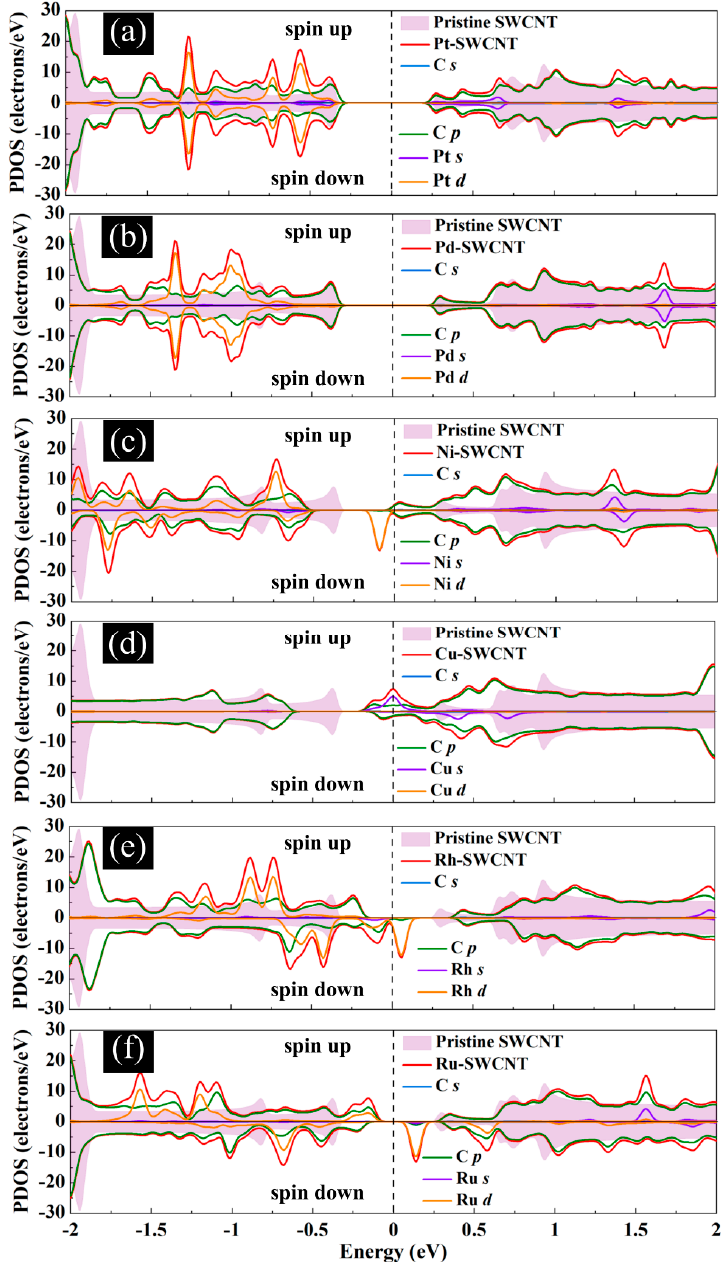
Figure 6. Total DOS curves for pristine SWCNT and ( a ) Pt-SWCNT, ( b ) Pd-SWCNT, ( c ) Ni-SWCNT, ( d ) Cu-SWCNT, ( e ) Rh-SWCNT, and ( f ) Ru-SWCNT systems. Projected density of states (PDOS) of the s and p orbitals of C atoms in SWCNT and s and d orbitals of metal atoms are also presented. The positive and negative values denote the spin-up and spin-down channels, respectively. The dashed lines indicate the Fermi level, which is set to zero.